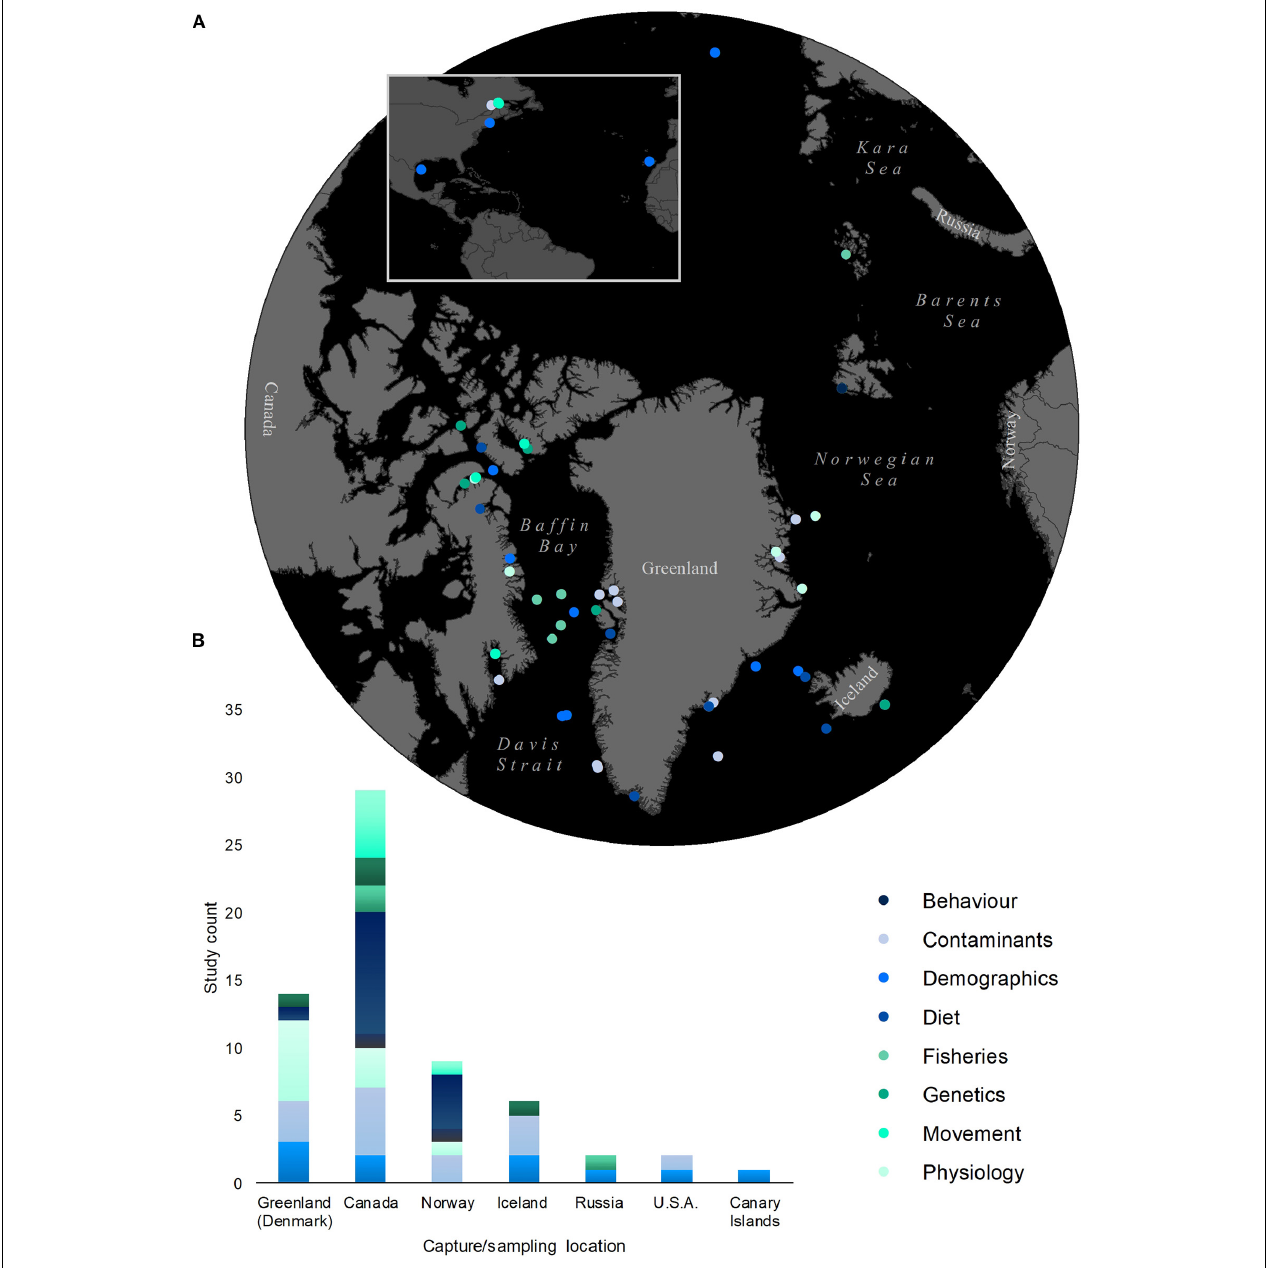
FIGURE 1 | Geographic coverage of Greenland shark studies by sampling location and research topic: (A) locations of Greenland shark capture/sampling (points represent sampling regions reported by each study, multiple points used for studies with several disparate sampling sites), (B) study count by country of Greenland shark capture/sampling and research focus (studies counted more than once where multiple sampled countries are